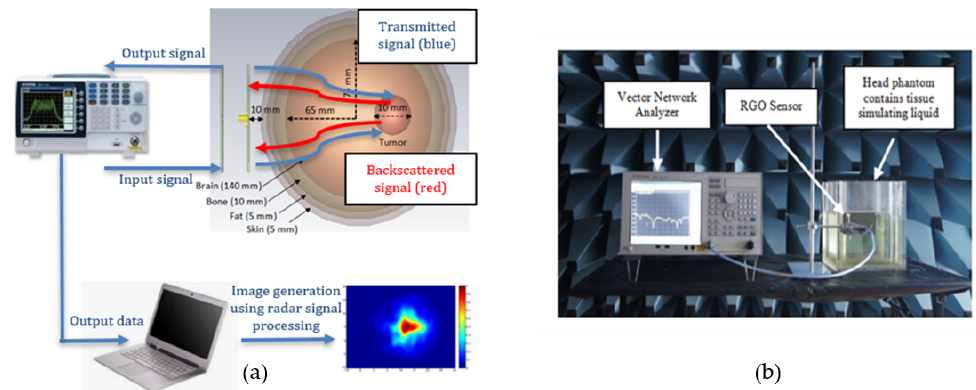
Figure 10. The diagram of the proposed brain tumor imaging system; ( a ) simulated, ( b ) measure-